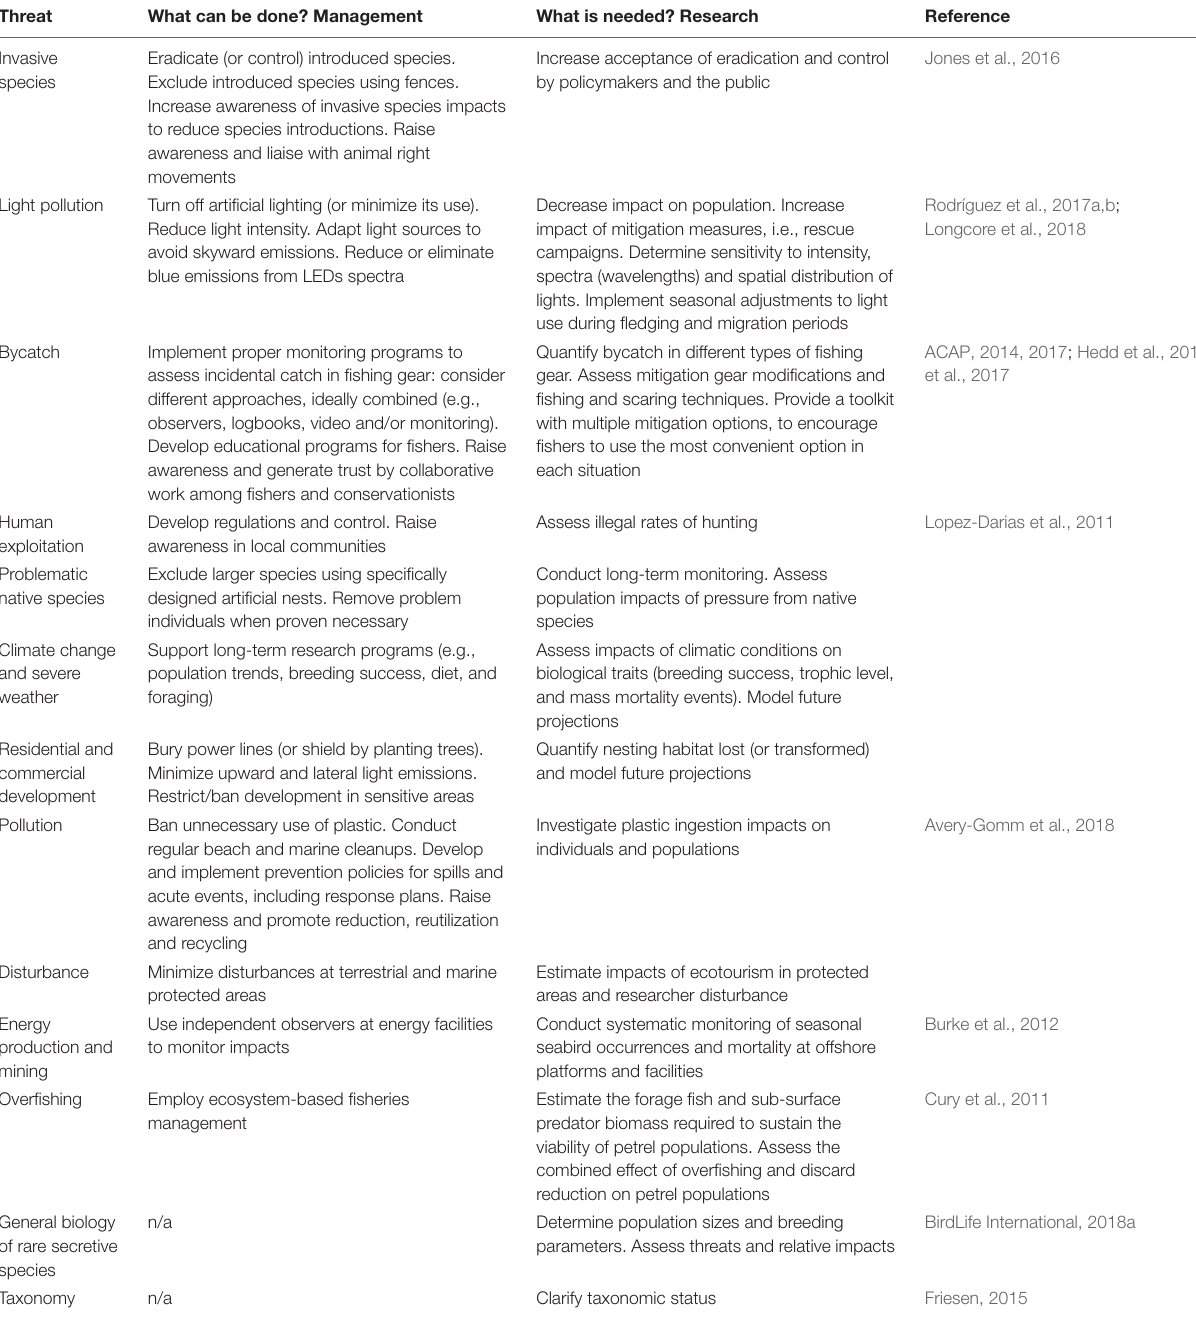
TABLE 2 | Measures and future research needs to reduce the severity of threats to petrels around the